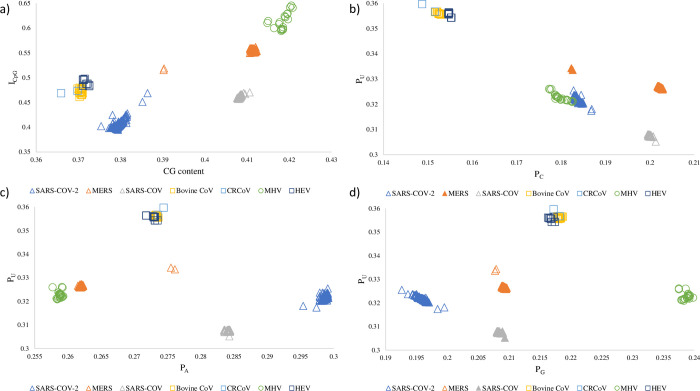
ICpG and nucleotide compositions of seven mammalian-specific coronaviruses.All genomes were MAFFT aligned and all non-conserved sequence ends were trimmed (see Materials and Methods). Panel a) shows that SARS-CoV-2 has the least ICpG in comparison to other coronaviruses from their natural hosts. Panels b), c) and d) compare the proportions of U (PU), to those of A (PA), C (PC), and G (PG), respectively. Each panel includes complete and high quality sequence data of 2666 SARS-CoV-2 genomes, 403 MERS genomes, 134 SARS-CoV genomes, 20 Bovine CoV genomes, 2 CRCoV genomes, 26 MHV genomes, and 10 HEV genomes.